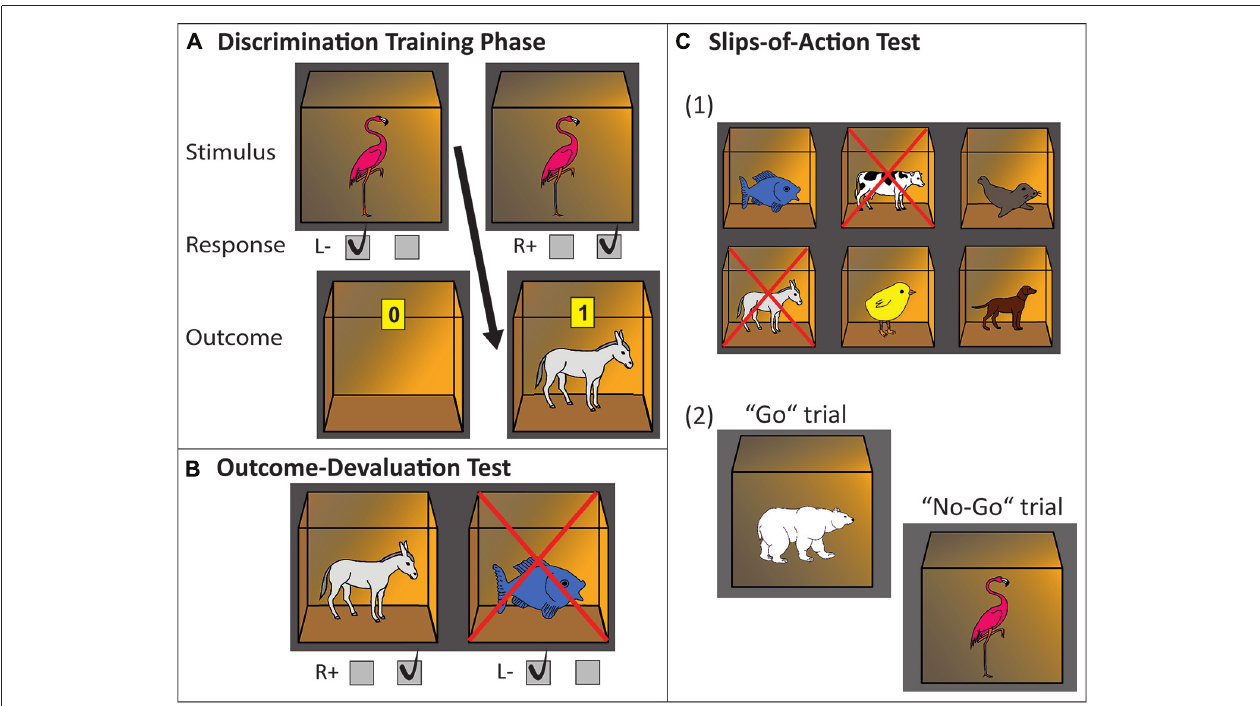
FIGURE 1 | Experimental paradigm, three-phase instrumental learning task. (A) Discrimination training phase. In this example, a flamingo stimulus printed on the front of a closed box indicates that pressing the right key will open the box and will be rewarded with a donkey and points inside of the box. Pressing the left key will not be rewarded (empty open box is revealed). (B) Outcome-devaluation test. In this example, two open boxes are presented with a donkey and fish inside. The cross superimposed on the fish signals this outcome is no longer worth any points. The accurate response in this example would be pressing the right key (which yielded the still-valuable donkey outcome during the learning phase). (C) Slips-of-action test. (1) Participants are first presented with the six outcomes. In this example, donkey and cow are superimposed with a cross, indicating that the response leading to these outcomes will now result in subtraction of points (devaluation). The other animal outcomes are still valuable. (2) Afterwards, in rapid succession animal stimuli are presented on the outside of the boxes. Participants are instructed to press the correct key if a stimulus indicates the availability of a still-valuable outcome inside the box (“Go”, example: polar bear stimulus signaling fish outcome), but withhold responding if the outcome inside the box has been devalued (“No-Go”, example: flamingo stimulus signaling donkey outcome).